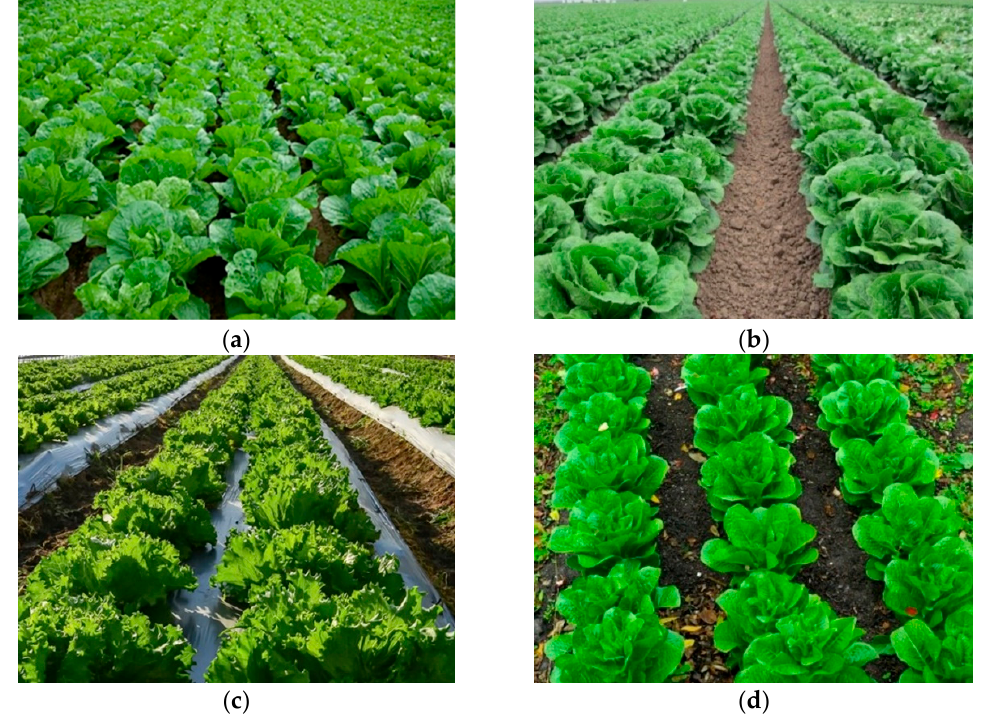
Figure 3. Some samples of the images captured by the RICS nodes in a crop of lettuce. Image resolution is 640 × 480 pixels. ( a ), ( b ) and ( d ) are images of romaine lettuce ( Lactuca sativa L. var. Longifolia ). ( c ) is the image of iceberg lettuce ( Lactuca sativa L. var. Capitata 'Iceberg' ).